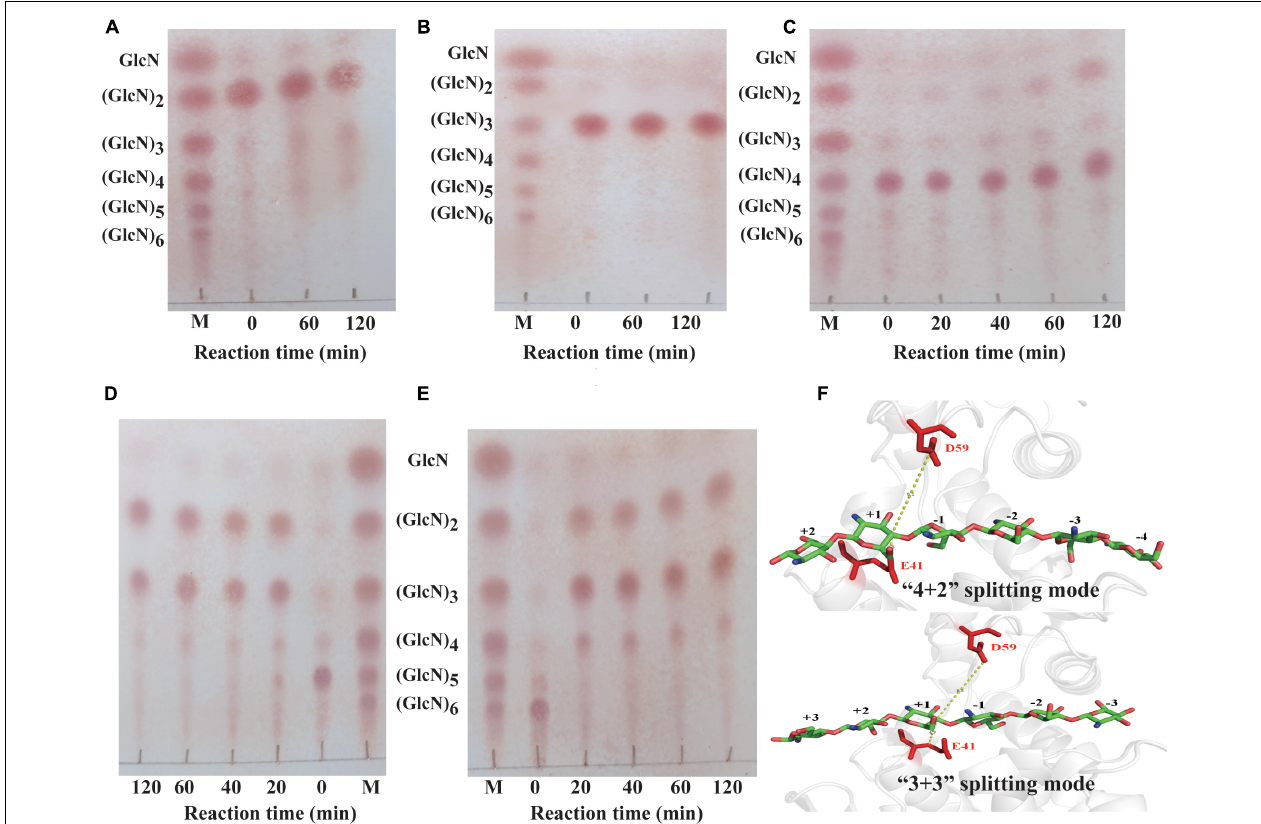
FIGURE 5 | Analysis of the hydrolytic pattern of Sh Csn46 toward different COSs. Chitobiose (A) , chitotriose (B) , chitotetraose (C) , chitopentaose (D) , chitohexaose (E) . M, standards sugars containing GlcN, (GlcN) 2 , (GlcN) 3 , (GlcN) 4 , (GlcN) 5 , and (GlcN) 6 . (F) The “4 + 2” and “3 + 3” splitting mode of ShCsn46 toward (GlcN) 6 . The amino acids residues E41 and D59 colored in red are catalytic active